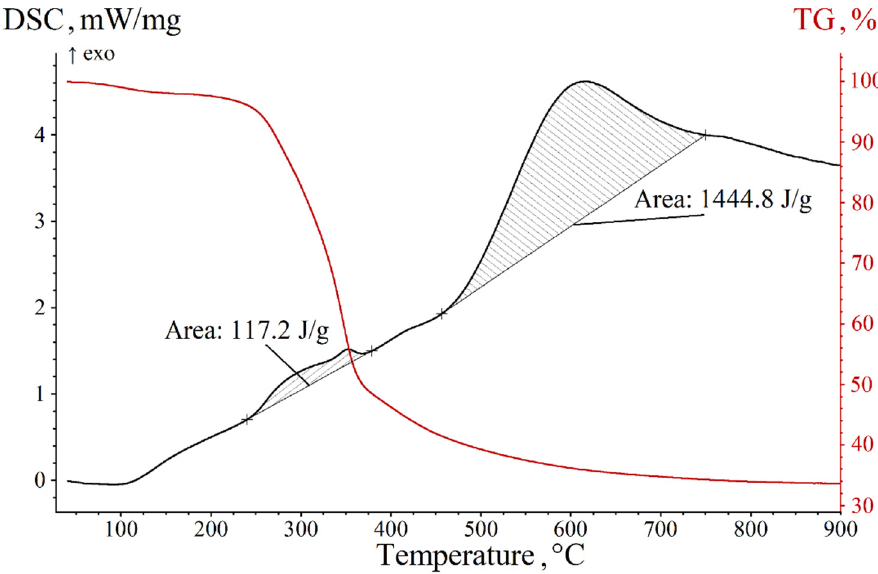
Figure 5. Results of the TG/DSC analysis of Siberian pine nutshell at a heating rate of 10 °C/min.